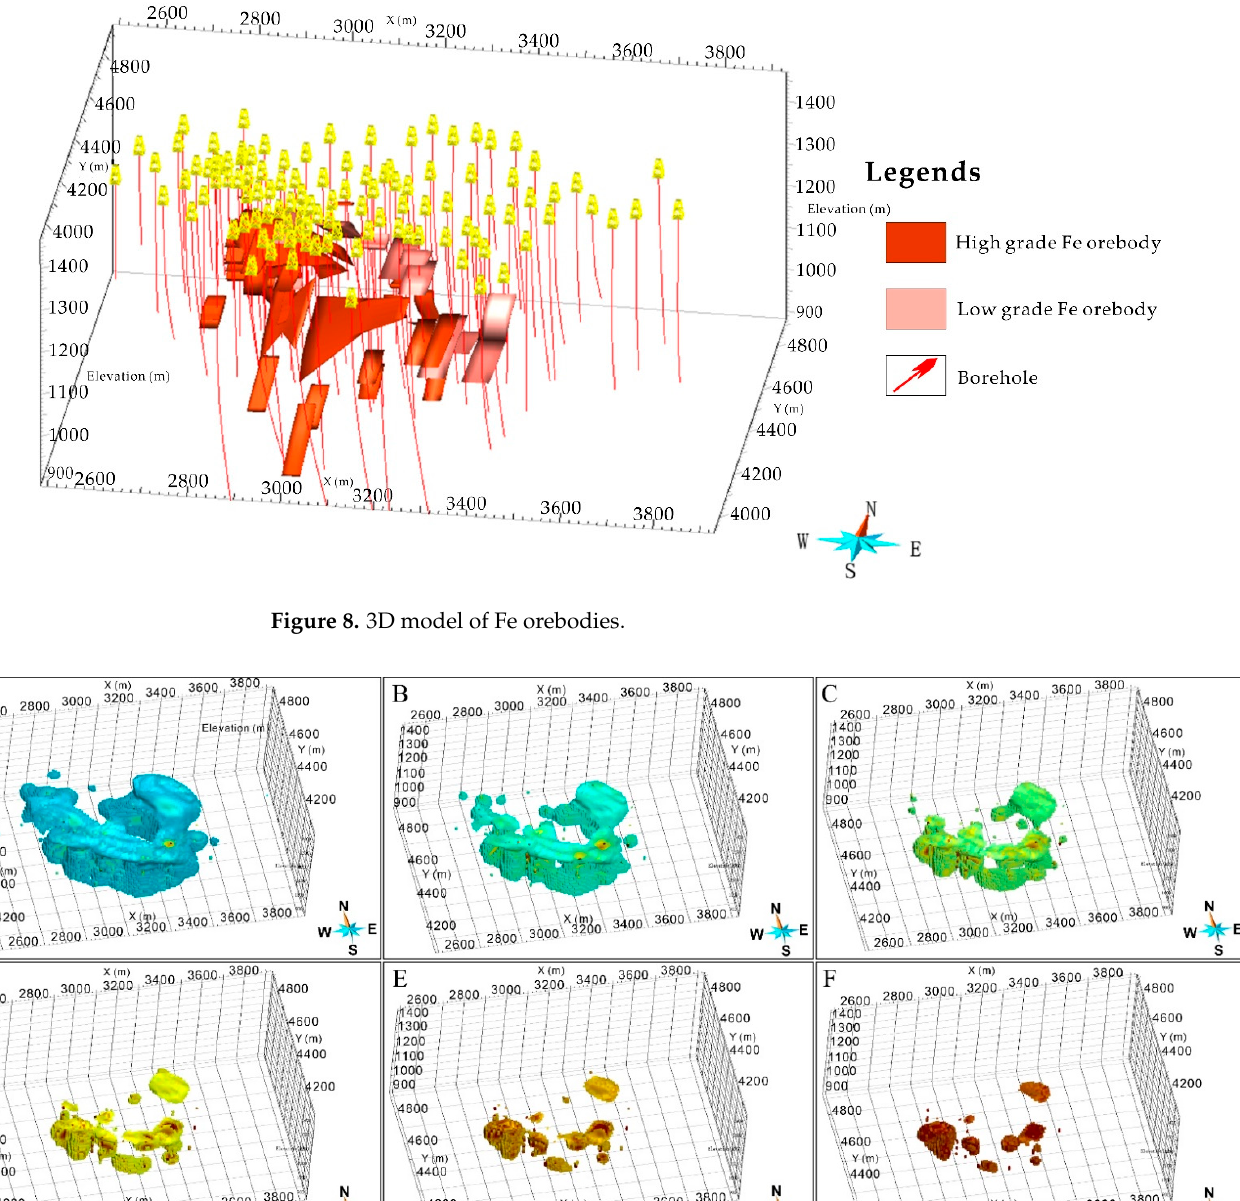
Figure 7. 3D model of Mo orebodies and Mo oxide orebodies.